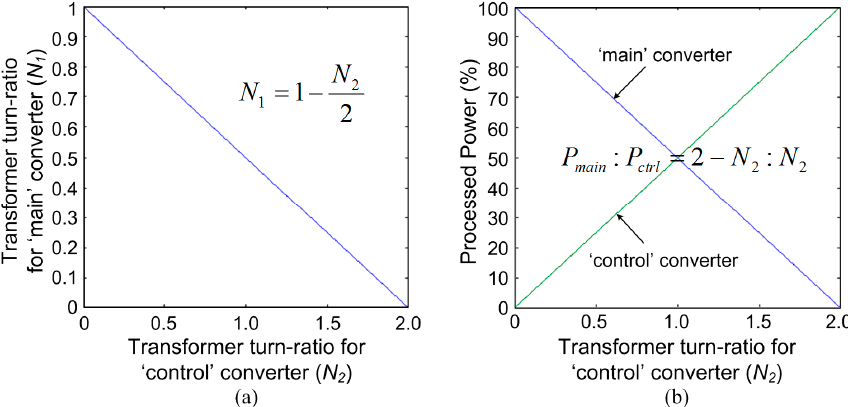
Figure 5. ( a ) Design example of the transformer turn-ratios ( N 1 and N 2 ) and ( b ) its power distribution between the ‘main’ and ‘control’ converters depending on N 2 , when the input and output voltages are assumed to be the same.